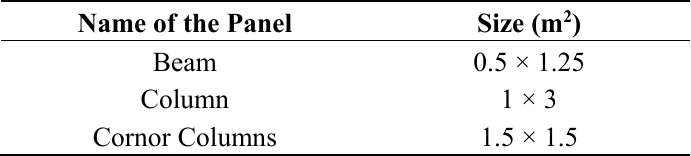
Figure 4. Design wind speed according to IS 875 for calculation of lateral load on building model. Table 2. Dimensions of the members for 120-story high building.